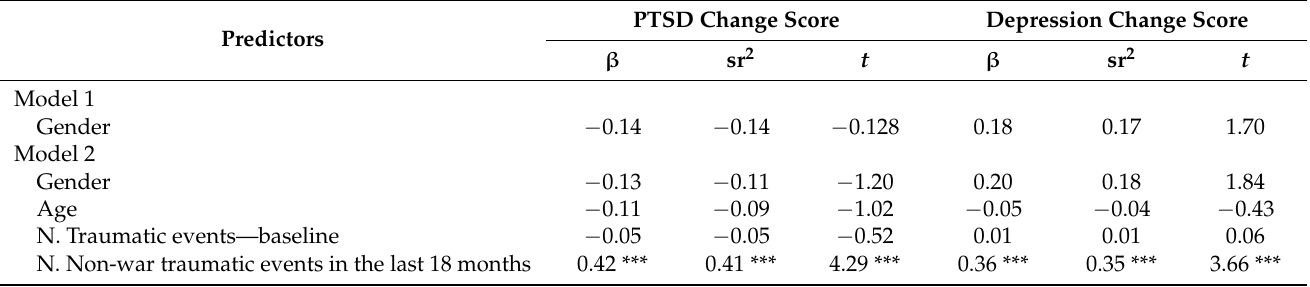
Table 3. Hierarchical regression analysis for variables predicting PTSD and depression change